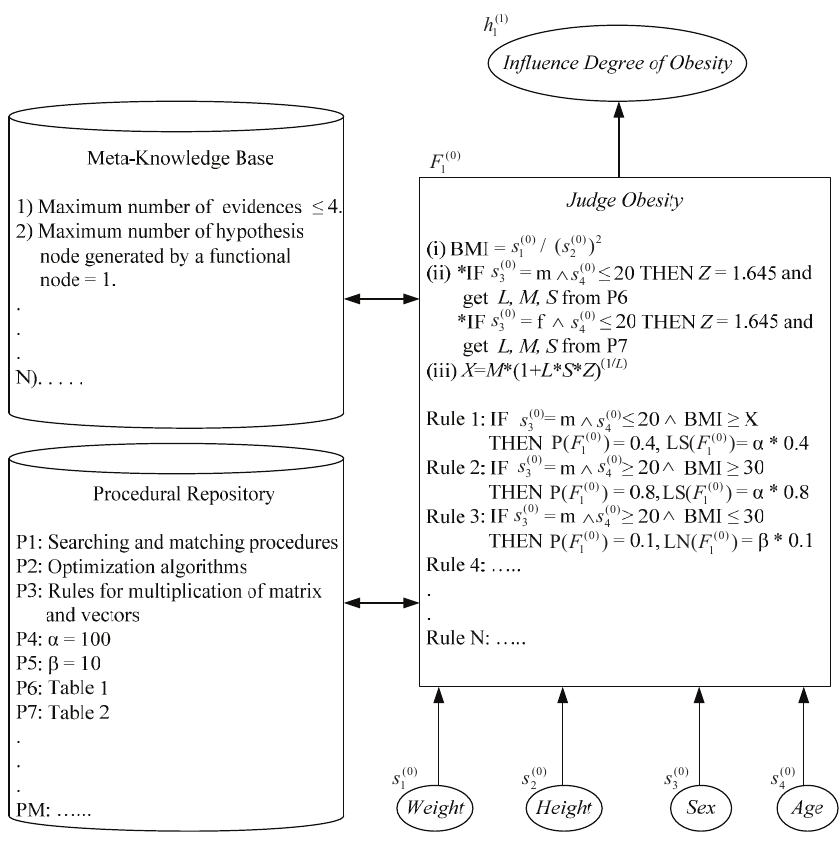
Figure 2. Branch 1 of HBFIN constructed by using